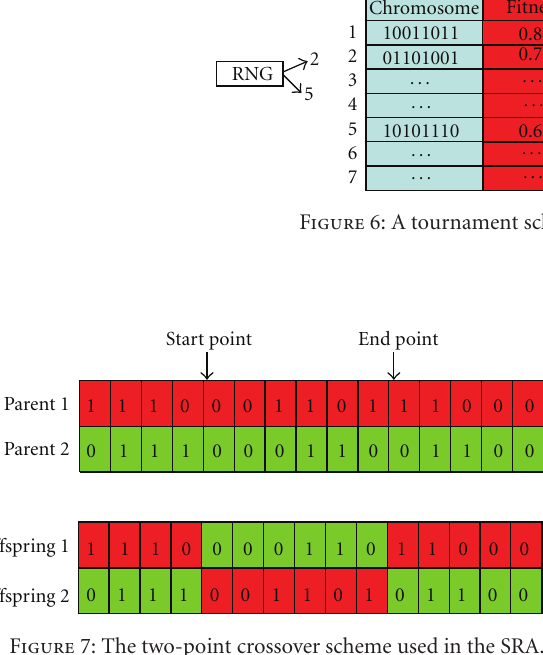
Figure 7: The two-point crossover scheme used in the SRA.